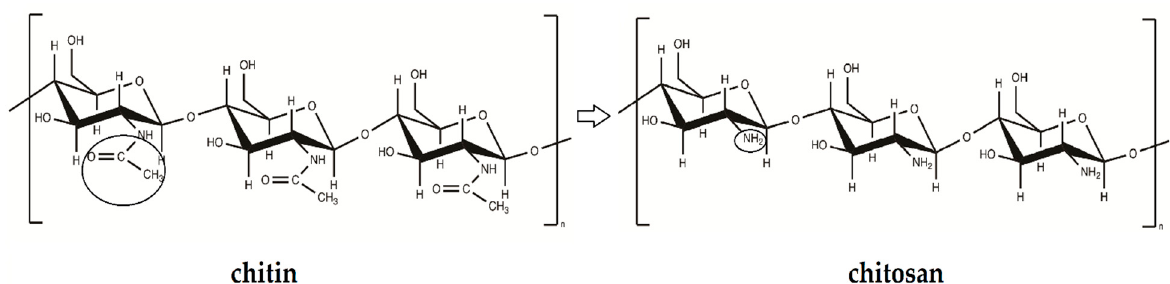
Figure 1. Scheme of the chemical deacetylation of chitin to chitosan.